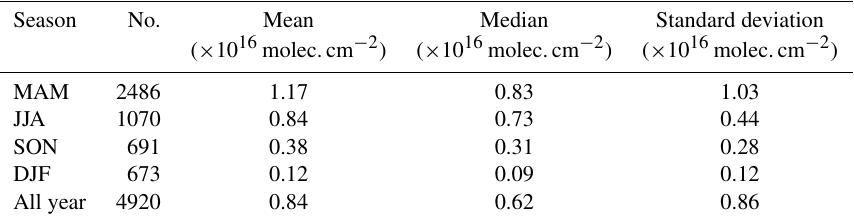
Table 2. Statistics of the retrieved NH 3 –OASIS measurements depending on the season (MAM – March, April, and May; JJA – June, July, and August; SON – September, October, and November; DJF – December, January, and February) and for the whole calendar year. (No. refers to number of spectra, mean, median, and standard deviation.) Total columns are given in 1 × 10 16 molec.cm − 2 .